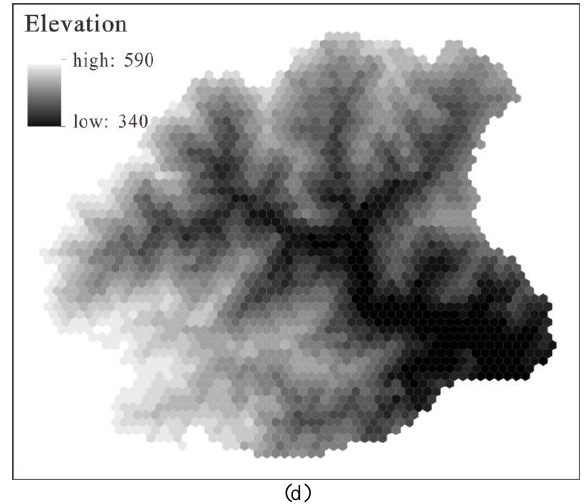
Figure 5. The comparison of generation results between hexagonal and square grid-based DEMs at 50m and 400m resolution:(a) square grid-based DEM with 50m resolution; (b) square grid-based DEM with 400m resolution; (c) hexagonal grid-based DEM with 50m resolution; (d) hexagonal grid-based DEM with 400m